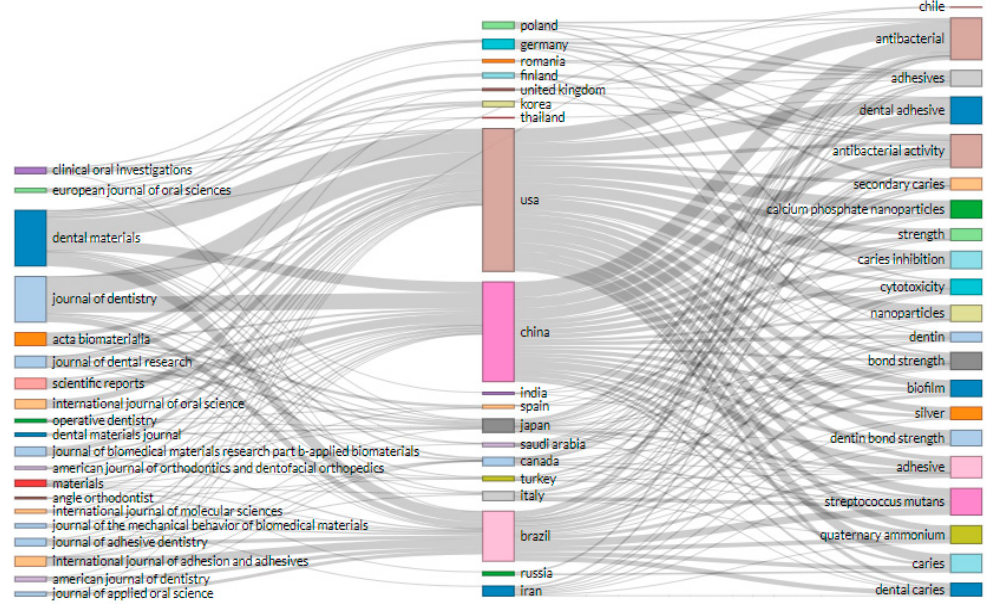
Figure 6. Three-factor plots of the relationship among keywords (left), countries (middle), and sources